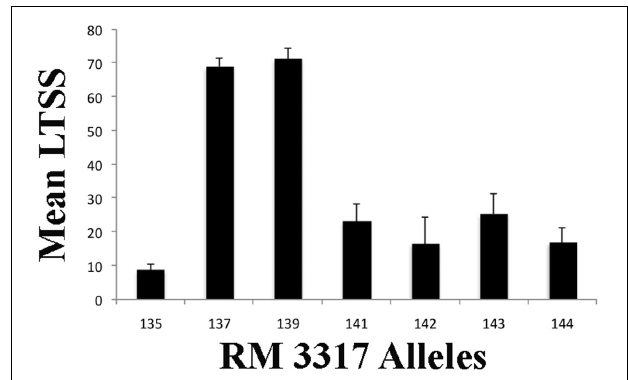
FIGURE 4 | Association of genotypic effects of RM3317 alleles with mean LTSS scores at the qLTSS4-1 locus. Shown is the mean low temperature seedling survival (LTSS) for the RMC accessions having the same RM3317 allele. Alleles 137 and 139 are predominantly found in JAPONICA accessions and alleles 135, 141, 142, 143, and 144 are predominantly found in INDICA accessions (Supplementary Table S4). Error bars indicate the standard error of LTSS for the accessions having a particular